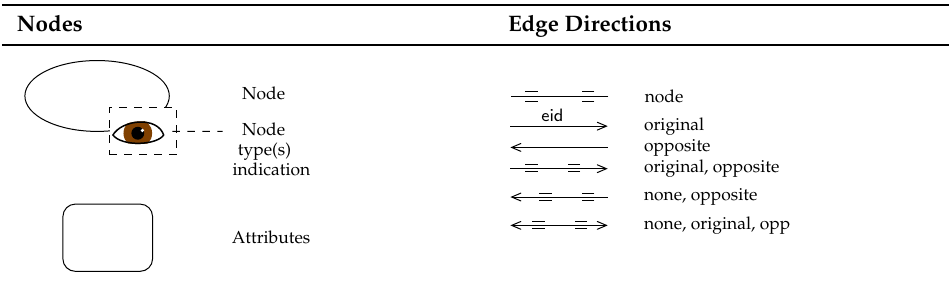
Table 11. DMQL graphical